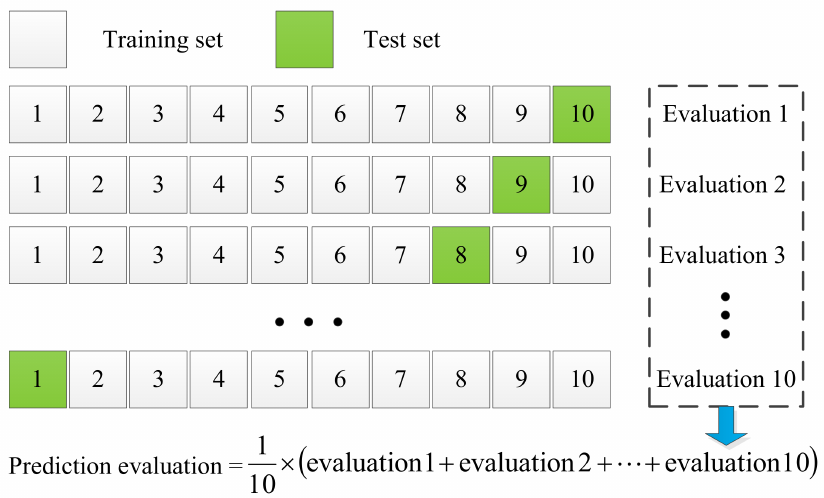
Figure 13. The process of 10-fold